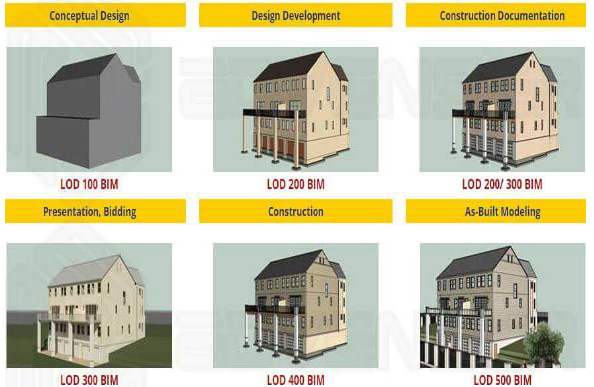
Figure 2. Relationship between LOD and degree of